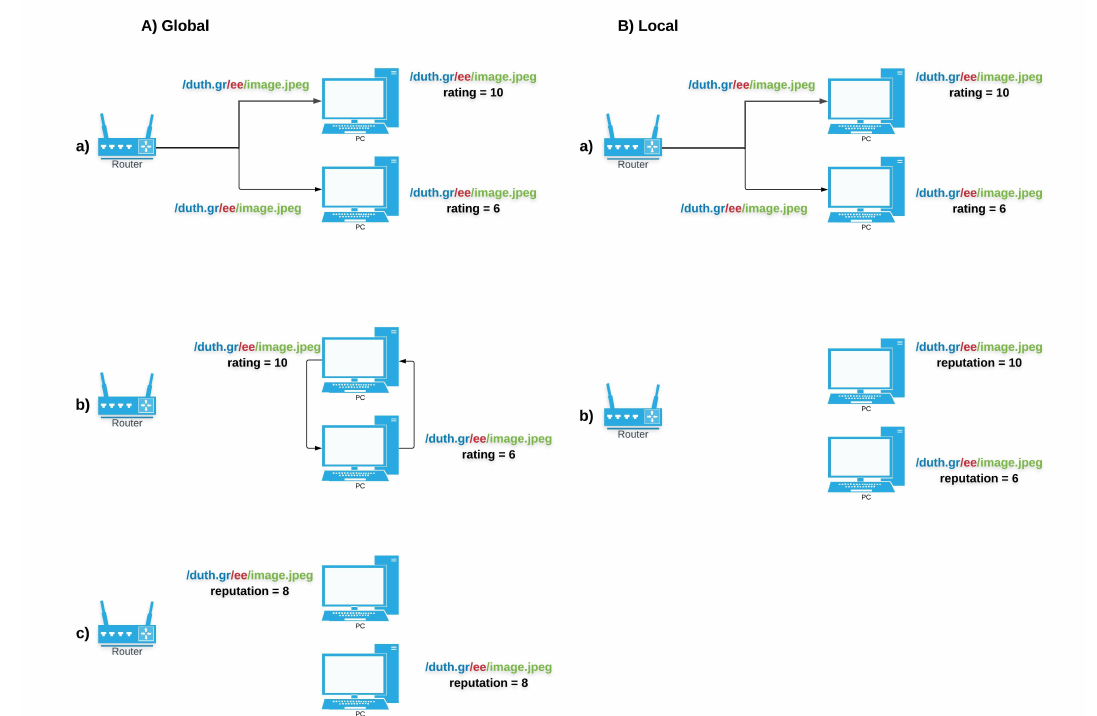
Figure 4. Global vs Local reputation: ( A ) Global: ( a ) Receiving content & assigning ratings, ( b ) Exchanging ratings, and ( c ) Computing reputation value individually. ( B ) Local: ( a ) Receiving content & assigning ratings, ( b ) Computing reputation value locally.